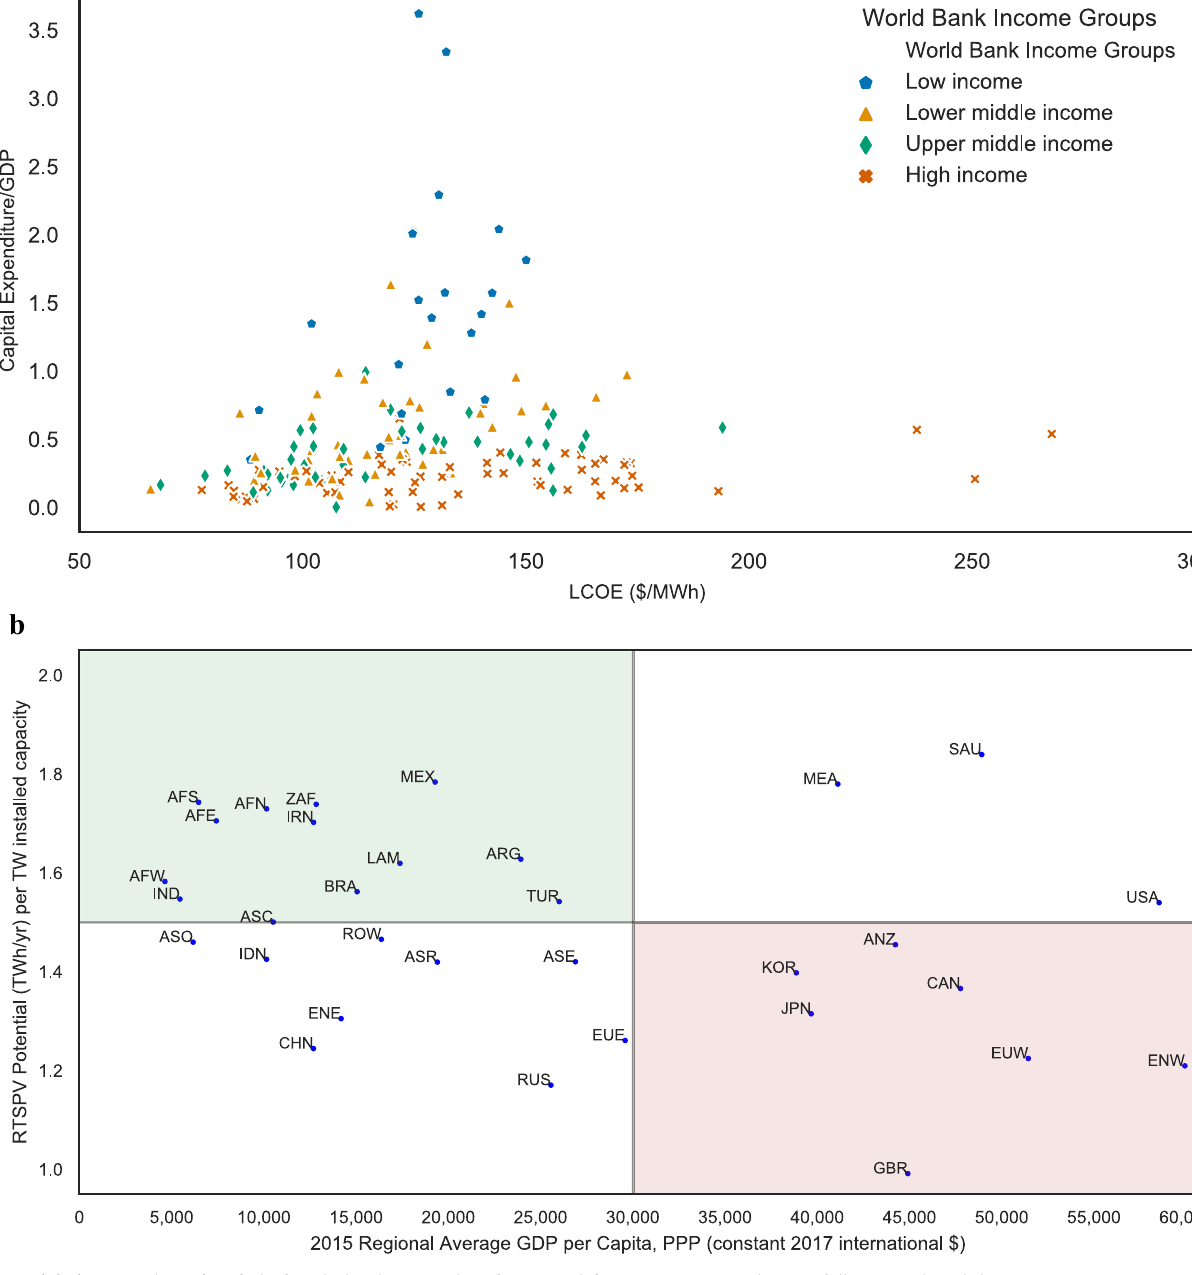
Fig. 8 Global economic and technical variation in accessing the potentials. a Disparity in achieving full potential, with low-income countries requiring capital investment greater than their respective 2015 GDP value to achieve full potential. b Distribution of 32 regions in relation to their relative yield factor and GDP per capita. The red region focuses on countries that currently have high rooftop PV rollout. The green region focuses on countries where RTSPV technology rollout will have maximum bene fi